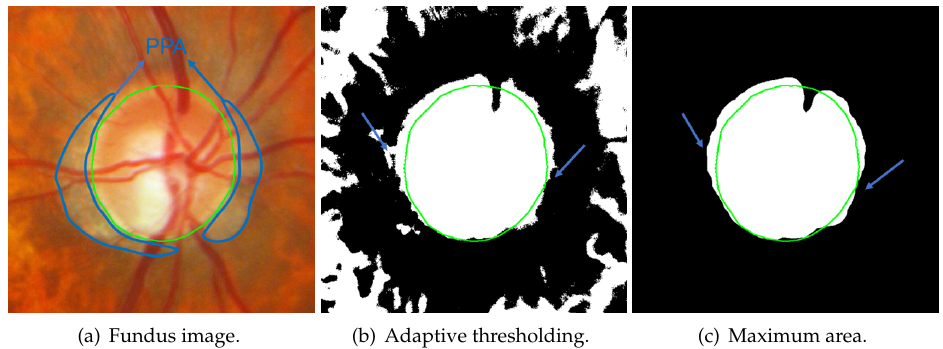
Figure 18. Adaptive thresholding can ignore some PPAs (green contour: ground truth, blue curves and arrows: PPA area. In ( b , c ), some PPA regions are ignored).